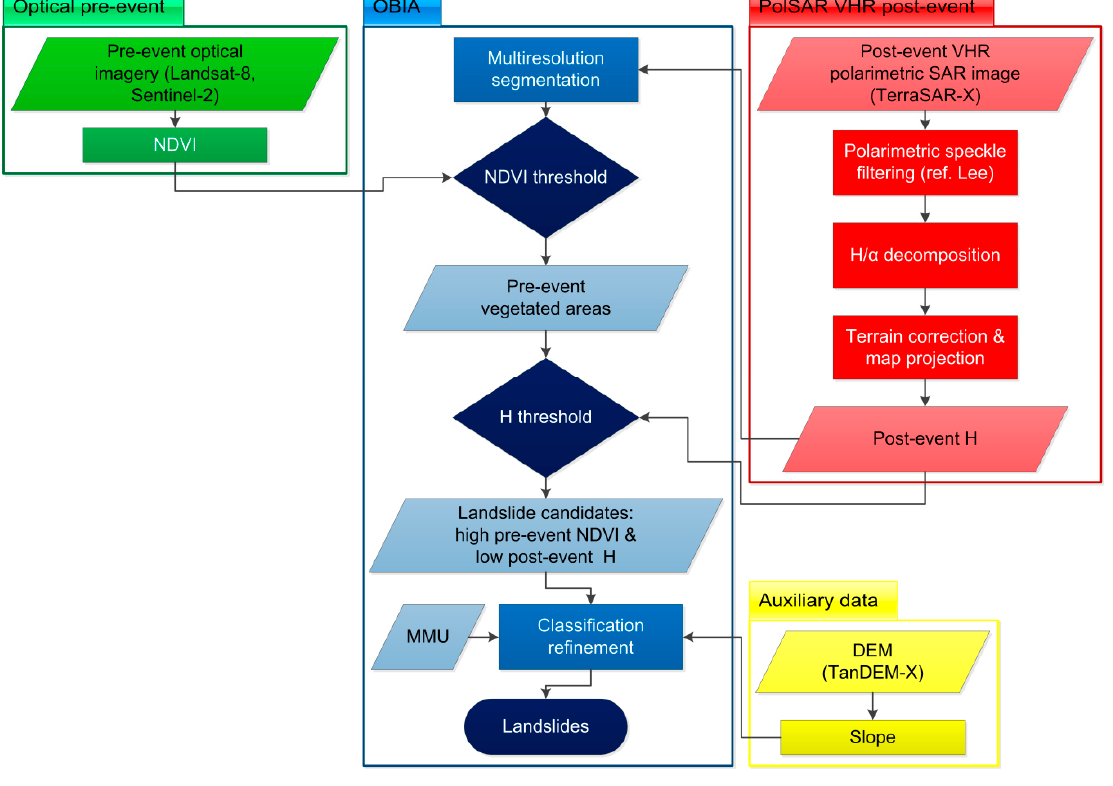
Figure 2. Workflow of the landslide detection procedure based on post-event polarimetric SAR and pre-event optical imagery.